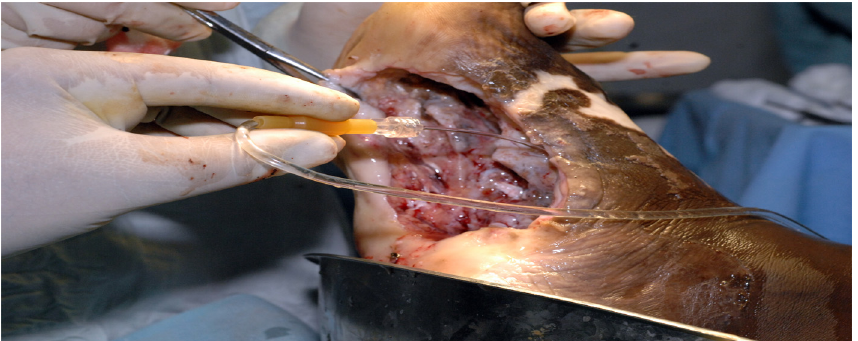
Fig 5. Photograph showing intraoperative wound irrigation with normal saline.